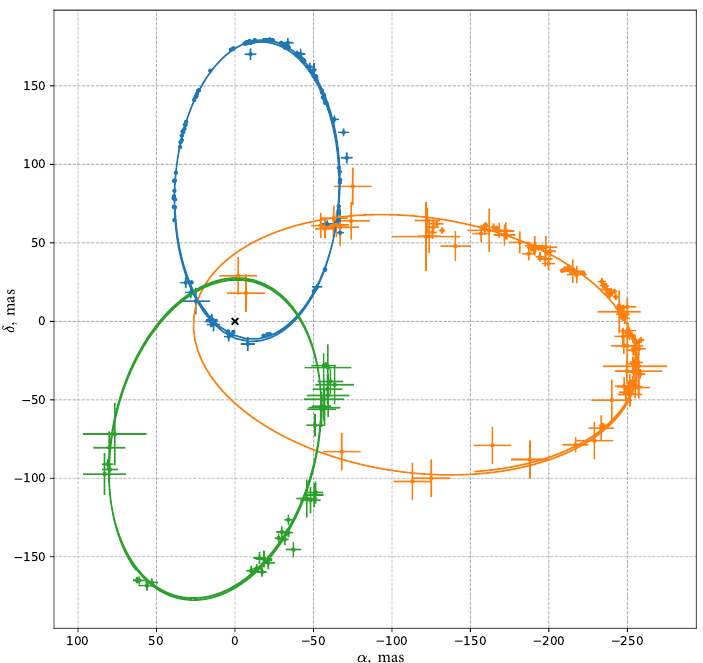
Figure 3. The best-fit Parameterized Post-Newtonian (PPN) orbits of S2 ( blue ), S38 ( orange ), and S55 ( green